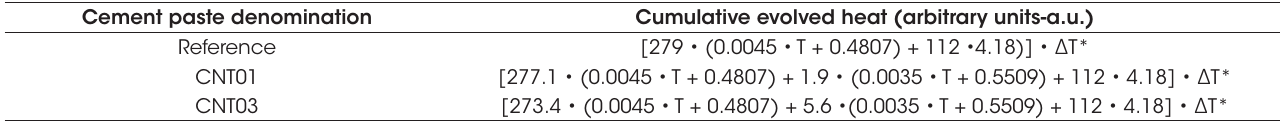
Cumulative evolved heat for each cement paste composition used for a 0.2 − liter volume